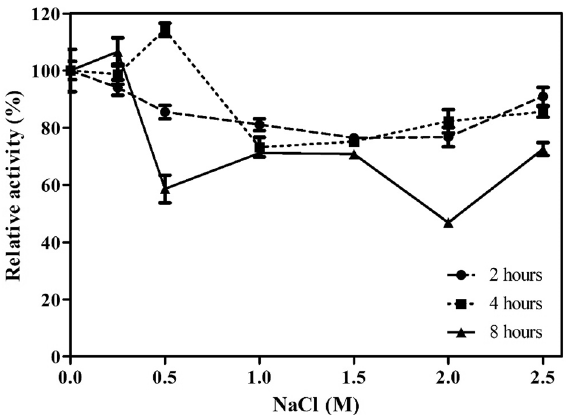
Figure 11. Residual activity after exposure of the enzyme to NaCl at concentrations of 0.1 to 2.5 M for up to 8 h at room temperature. Values are represented as the mean percentage ± standard deviation.